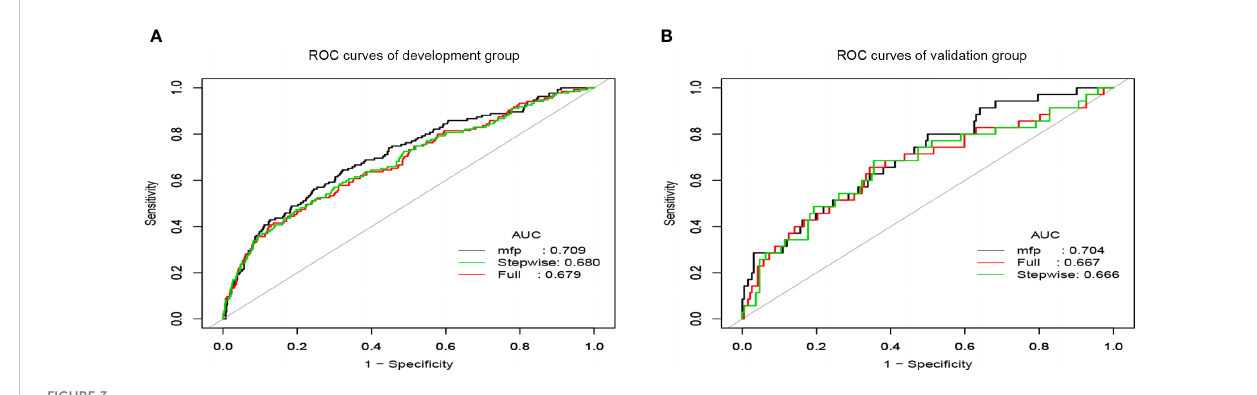
FIGURE 3 The ROC curves of prediction models. (A) ROC curves of the development group. (B) ROC curves of the validation group.